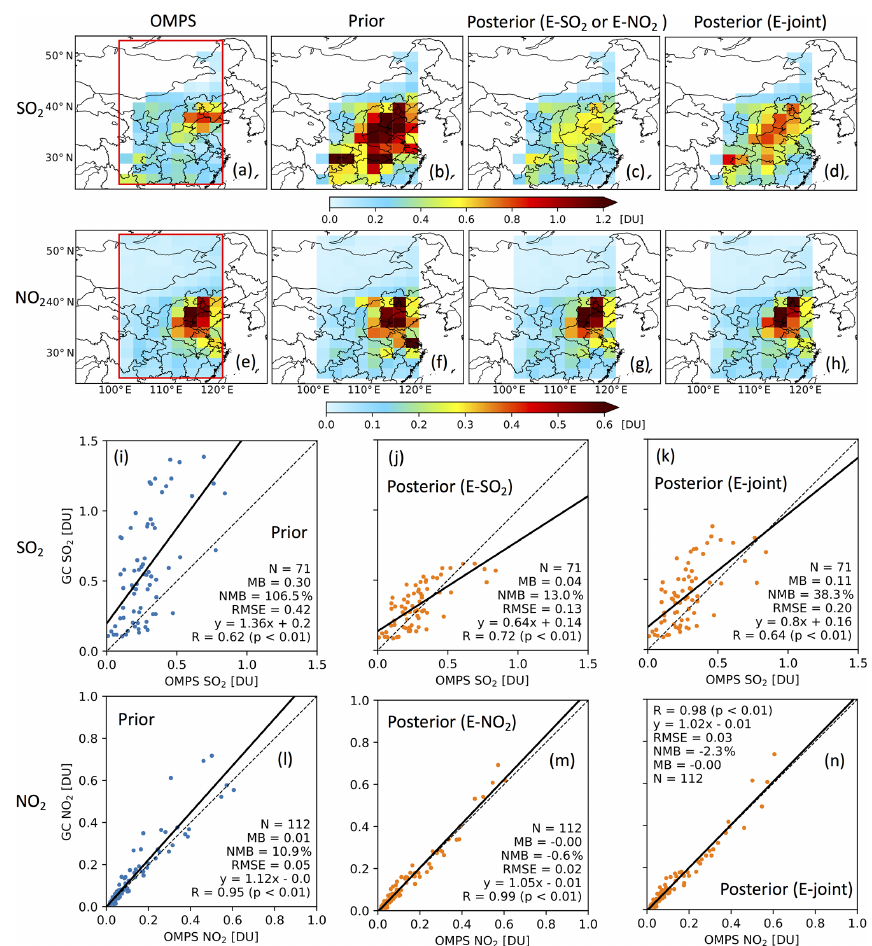
Figure 3. Comparisons of VCDs of SO 2 and NO 2 from the OMPS and the GEOS-Chem prior and posterior simulations in October 2013 over China. The first row is SO 2 VCDs from the OMPS (a) , the prior simulation (b) , the E − SO 2 posterior simulation (c) , and the E-joint posterior simulation (d) . The second row is NO 2 tropospheric VCDs from the OMPS (e) , the prior simulation (f) , the E − NO 2 posterior simulation (g) , and the E-joint posterior simulation (h) . The third row is the SO 2 VCD scatter plots of the GEOS-Chem prior (i) , the E − SO 2 posterior (j) , and the E-joint posterior (k) versus the OMPS, respectively. The last row is the NO 2 tropospheric VCD scatter plots of the GEOS-Chem prior (l) , the E − NO 2 posterior (m) , and the E-joint posterior (n) versus the OMPS, respectively. The linear correlation coefficient ( R ), linear regression equation, root mean squared error (RMSE), normalized mean bias (NMB), mean bias (MB), and number of observations ( N ) are shown over scatter